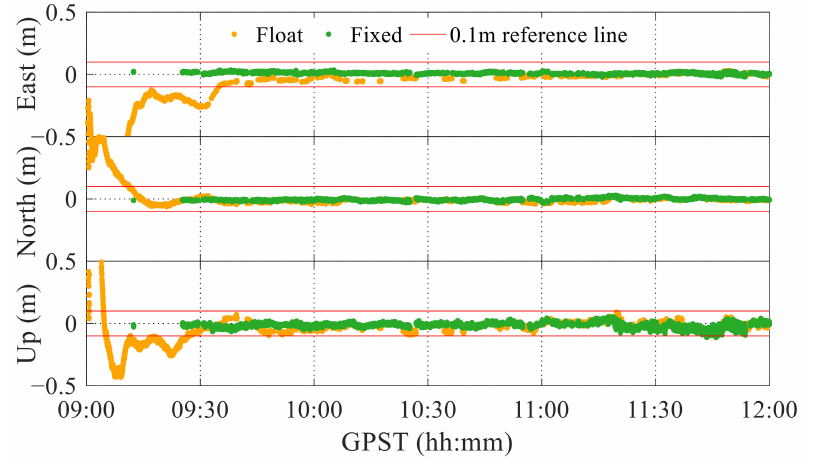
Figure 7. Results of full ambiguity resolution for GPS L1 + Galileo E1